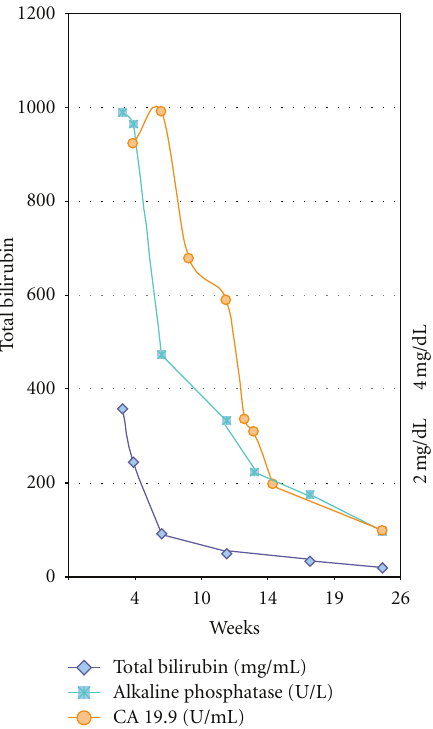
Figure 2: Evolution of liver function tests and tumor marker (CA 19.9) in patient A.